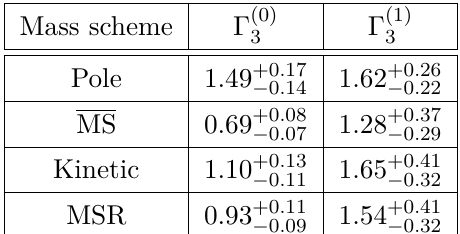
Table 8. Values of Γ 3 [ ps − 1 ] contribution to the total decay widths at LO ((0)) and NLO((1)) for various schemes of the charm-quark mass. For the central values, we set µ = 1 . 5 GeV, while the errors result from the variation of the scale µ in the range (1 GeV , 3 GeV ) . For the pole scheme, we use m pole = 1 . 49 GeV, evaluated using the relation (2.52) to order α c three loops, respectively, see eqs. (2.57) and